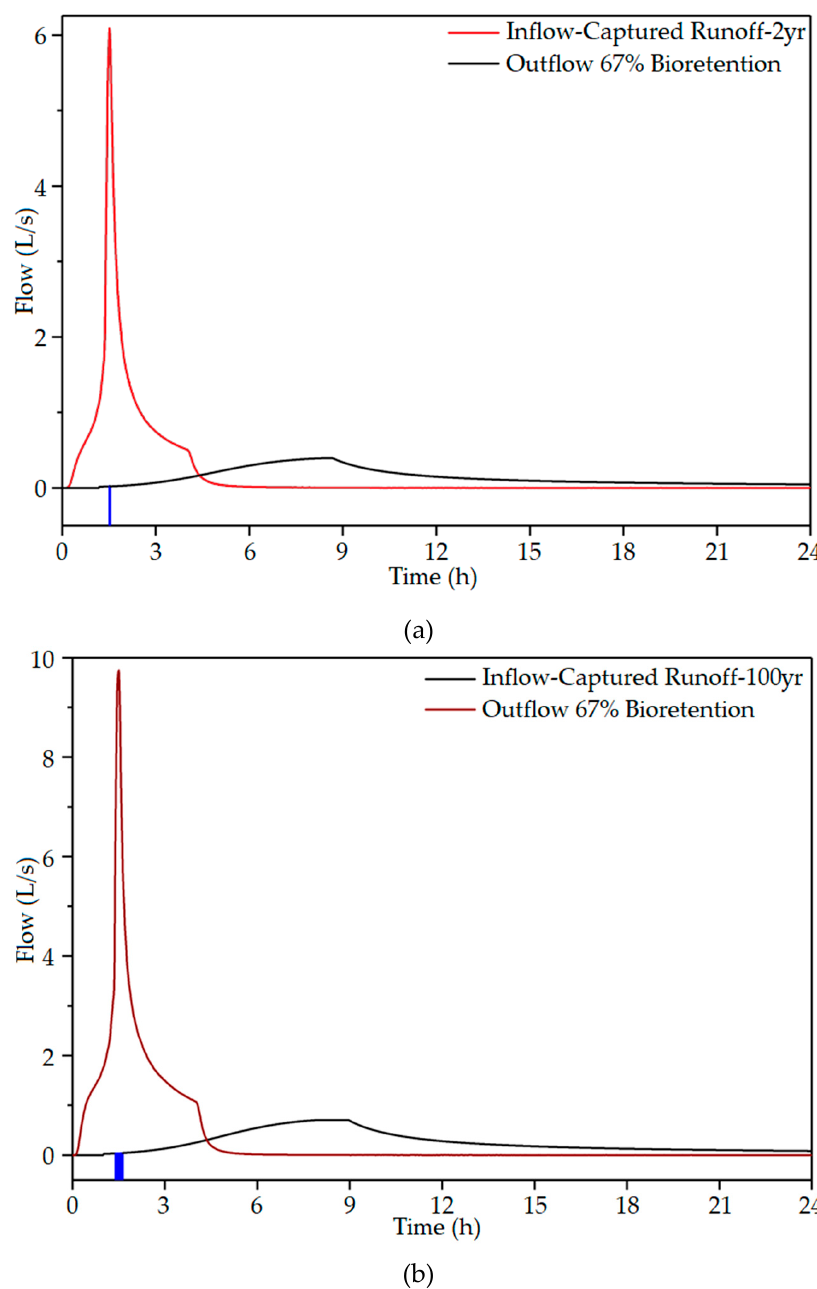
Figure 15. The modified inflow and outflow hydrographs for; ( a ) 2-year storm; ( b ) 100-year storm.